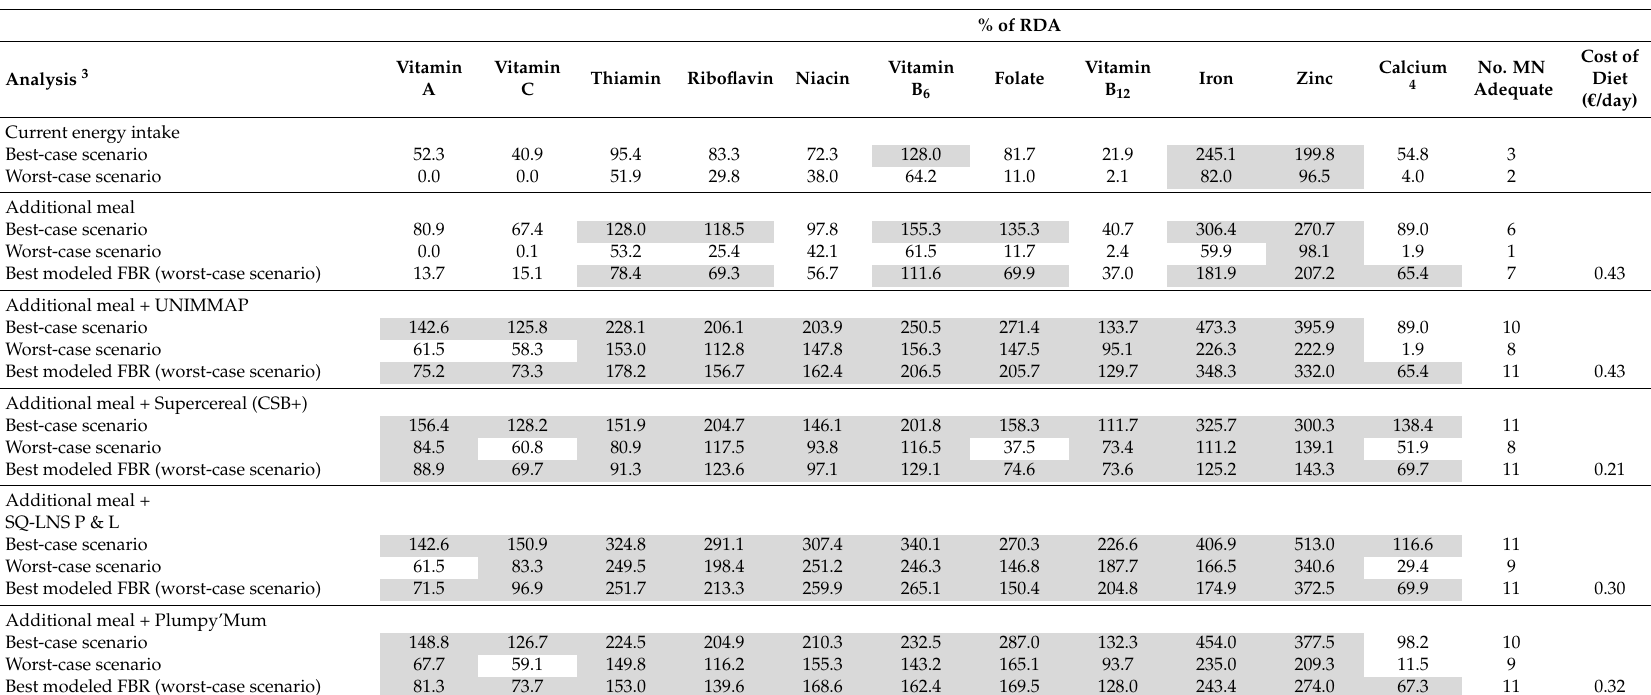
Table 5. The nutrient content of worst-case and best-case scenario diets without food-based recommendations (module III), and food-based recommendations with the greatest nutritional impact, expressed as a percentage of Recommended Dietary Allowances (RDA) among lactating women 1,2